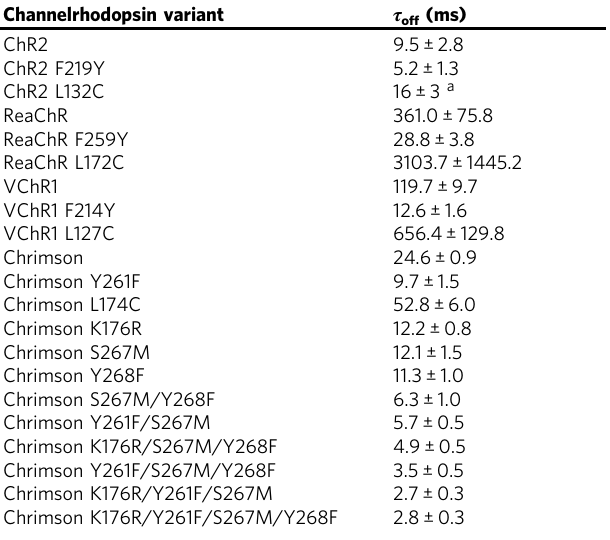
Table 1 Off-kinetics ( τ off ) of channelrhodopsin variants Channelrhodopsin